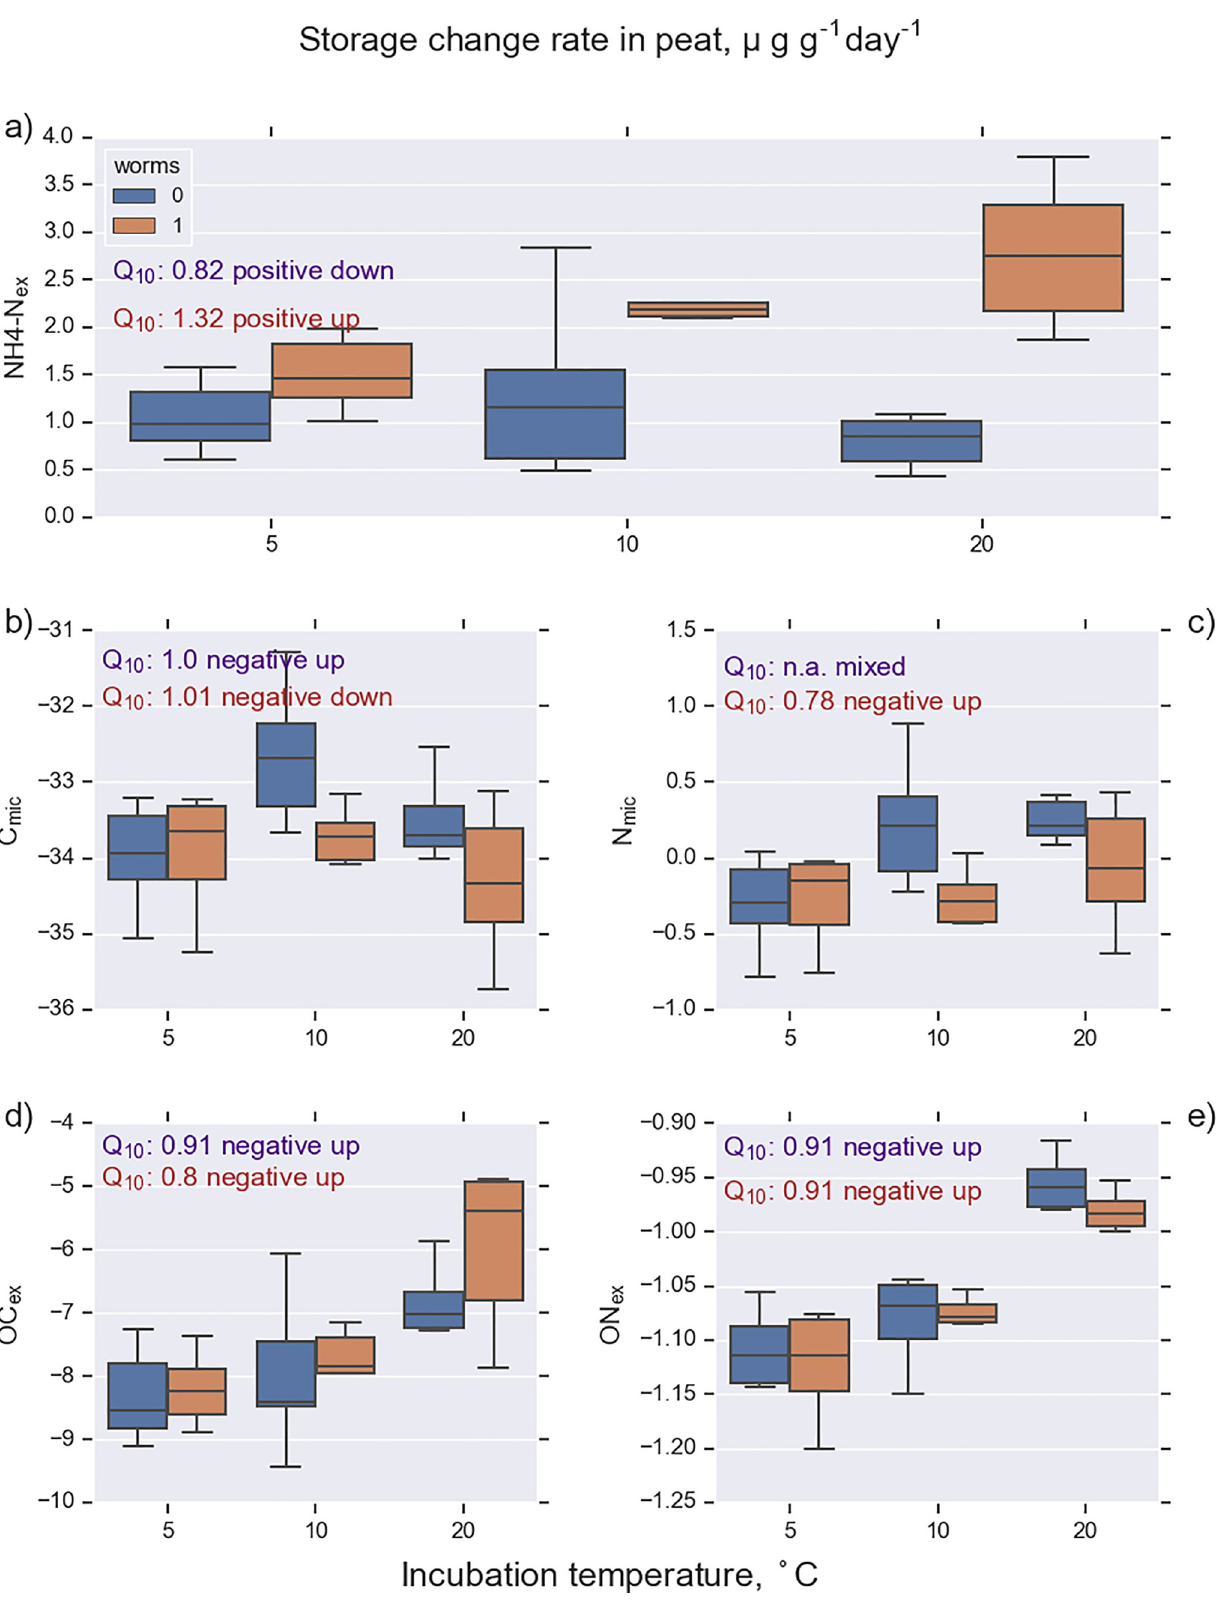
Fig 6. Rate of change in K 2 SO 4 -extractable C and N pools in peat samples (n = 36). Incubation was conducted at 5, 10, and 20˚C with (worms 1) and without enchytraeid worms (worms 0). The measured pools were ammonium (NH 4 -N ex ), microbial C, microbial N, total organic C (OC ex ), and total organic N (ON ex ). See Table 1 for